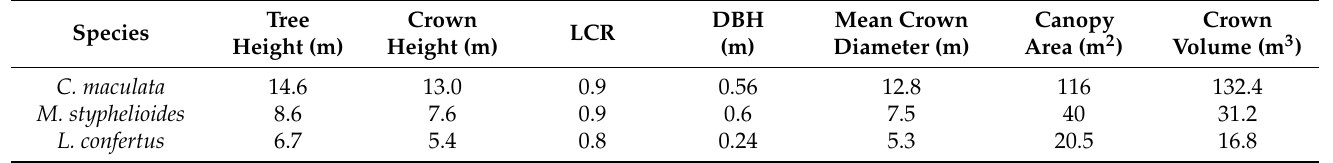
Table 1. Characteristics of the C. maculata , M. styphelioides and L. confertus used in these experiments.